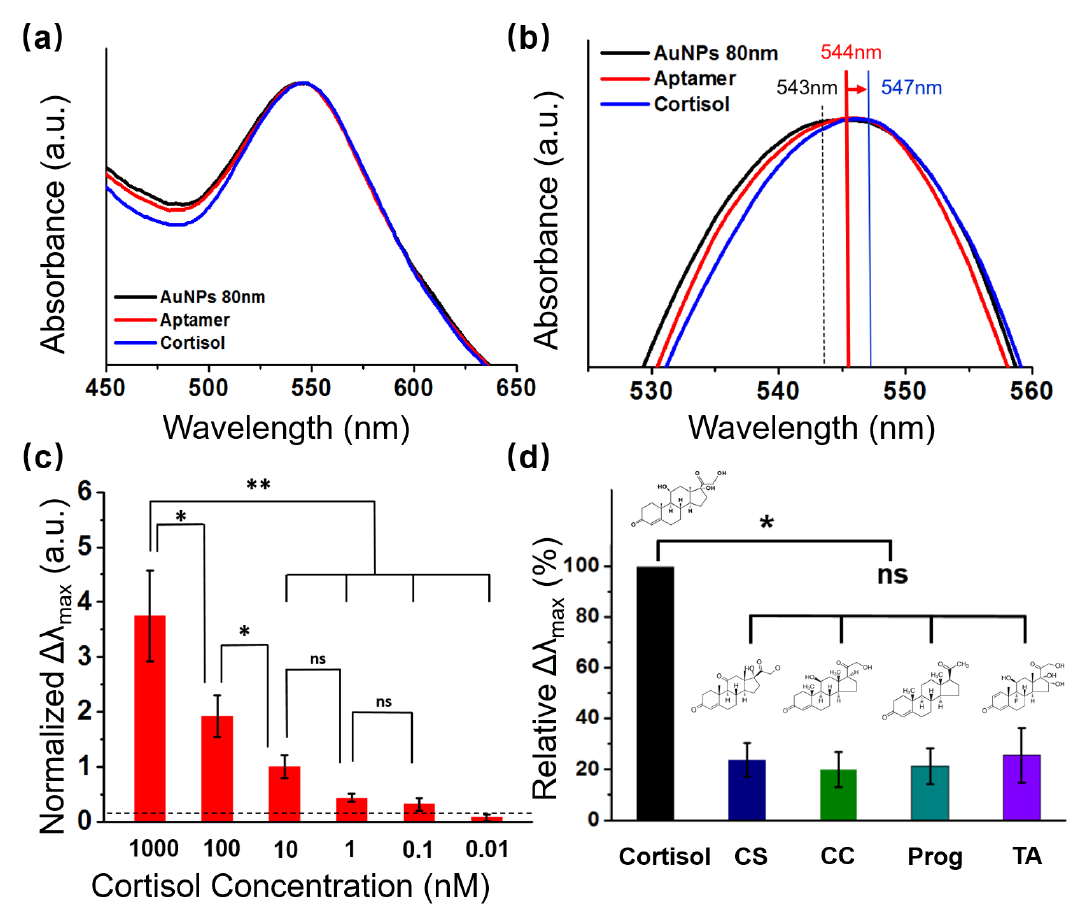
Figure 4. Absorption performance and selectivity test of the LSPR biosensors. ( a ) UV-Vis spectra showing shifting of the extinction peaks following aptamer and cortisol conjugation with 80 nm AuNPs; ( b ) magnified UV-Vis spectra showing the peaks shift, following aptamer and cortisol conjugation with AuNPs; ( c ) cortisol detection using the sweat biosensor at different concentrations of cortisol (0 – 1000 nM) ( n = 4; * p < 0.05, ** p < 0.01, Student’s t -test); ( d ) selectivity test of the LSPR biosensor evaluated by comparing the relative maximum extinction peak shift (Δλmax) in response to 1 nM cortisol, cortisone (CS), corticosterone (CC), progesterone (Prog), and triamcinolone (TA) ( n = 4; * p < 0.05, ** p < 0.01, ns = no significant difference, Student’s t